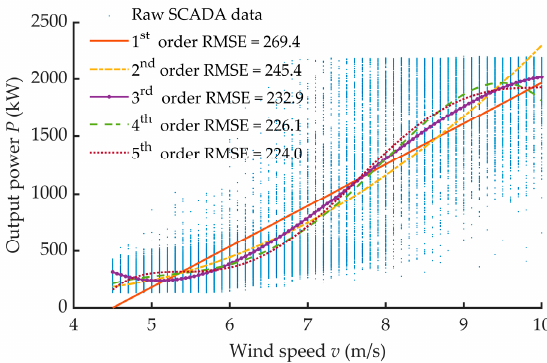
Figure 13. Comparison between the relationship of wind speed and power with different fitting orders.